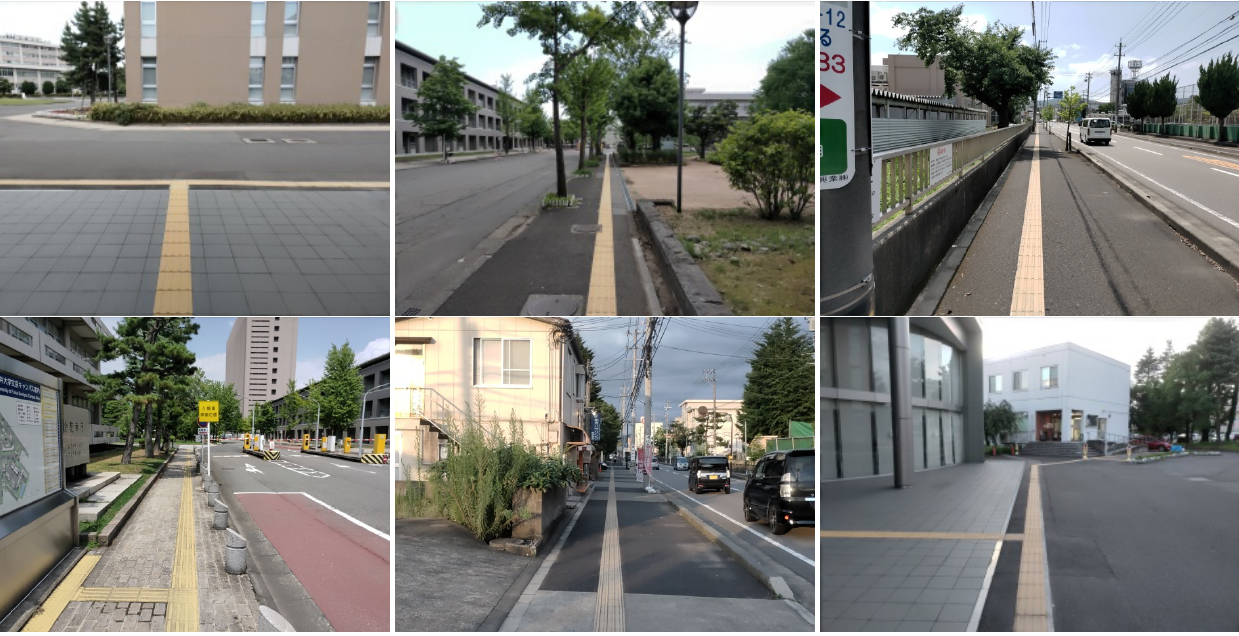
Figure 1. Examples of the Braille blocks from an egocentric